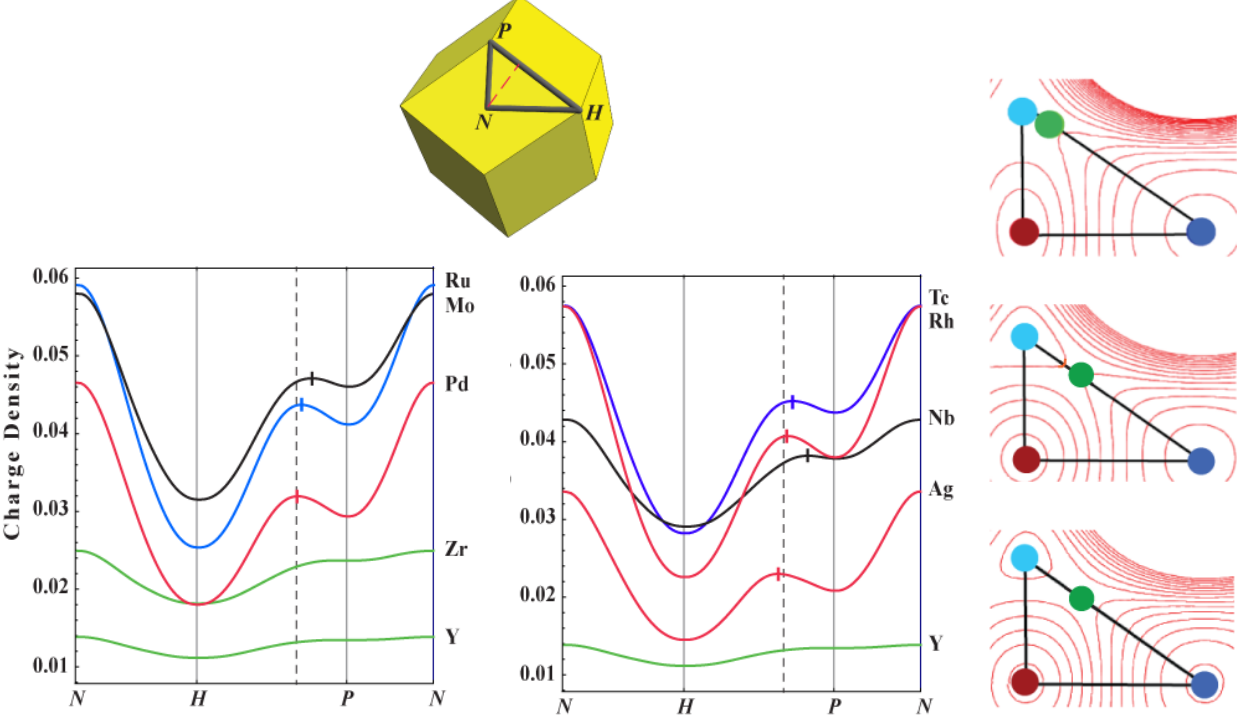
Figure 5. (left) The electron density in AU as generated using the LASTO software package for the 4 d metals around the N–H–P–N loop. The required ring CP between the octahedral and tetrahedral cage CPs is located at the electron density maximum along the H–P loop segment and is designated with a cross. The 4 d metals show identical trends. For the stable FCC metals, this ring CP is located very close to the dashed line designating its ideal position for an FCC transition metal crystal. (The position of the ring CP (green disks) may also be discerned from the contour graphs of the electron density in the appropriate face of the Wigner–Seitz cell for forced FCC : (from top to bottom) V, Cu, and Ir. The graphs were divided into two sets to enhance readability. Lattice constants provided in Table